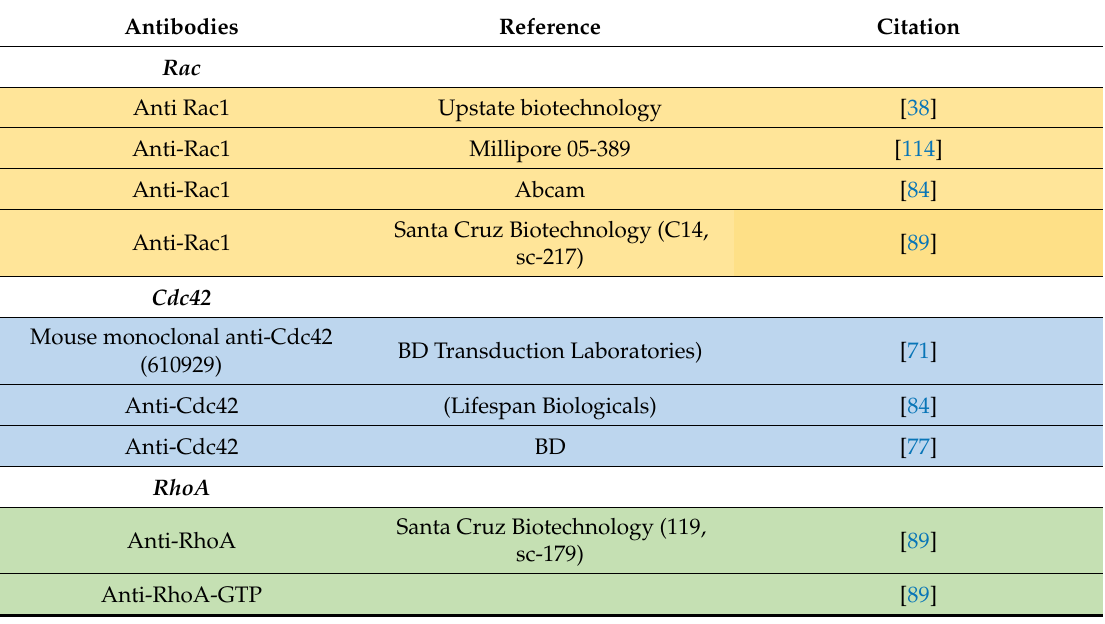
Table 4. Available antibodies for immunostaining of Rho GTPases in zebrafish.